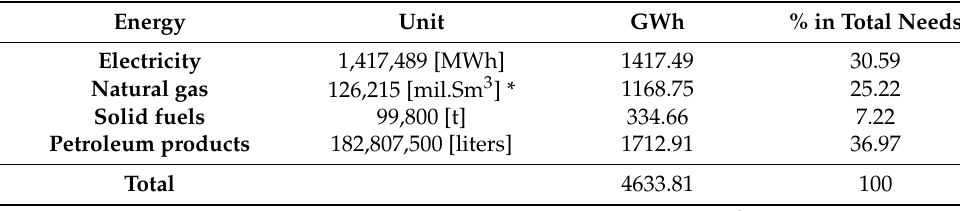
Table 3. Sarajevo Canton energy needs for 2018